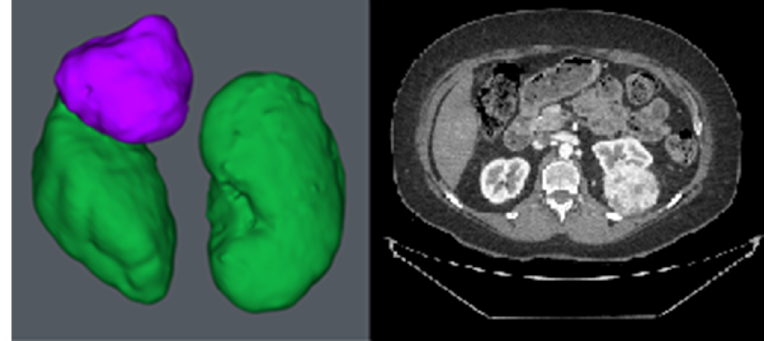
Figure 2. ( Left ): 3D volume rendering of the segmented regions (kidney and renal cancer in blue and purple). ( Right ): 2D kidney and renal cancer image.